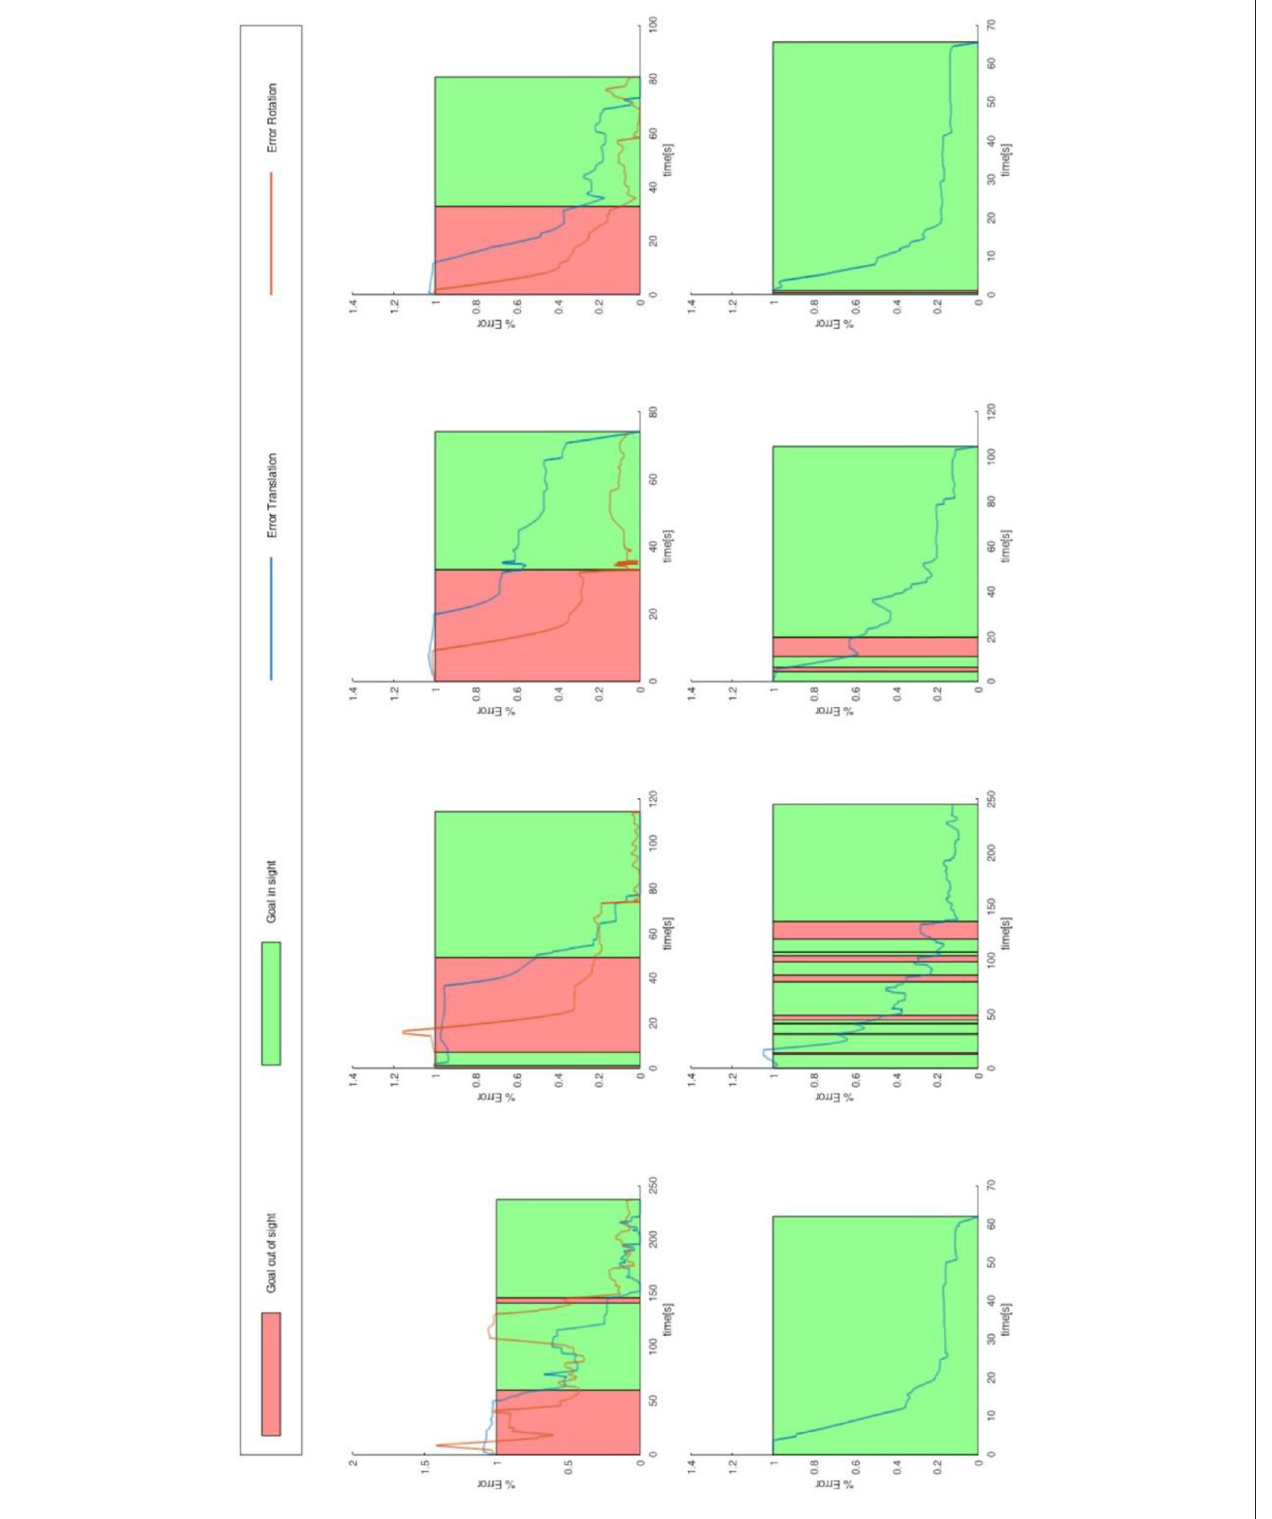
FIGURE 10 | Relative error of translation and rotation of the end effector, with 100% of the errors in the start position and 0% of the errors at the target. The data shown are eight executions of a subject. The upper row show the task “Set Camera View” and the lower row show the task “Manipulation.” The intervals in which the subject could not see the target are highlighted in red. The outer rows were done with the Novint Falcon 3d Haptic Controller, the two inner rows with keyboard and mouse. No rotation target was defined for the task “Manipulation,” therefore no rotation error is specified for this task.